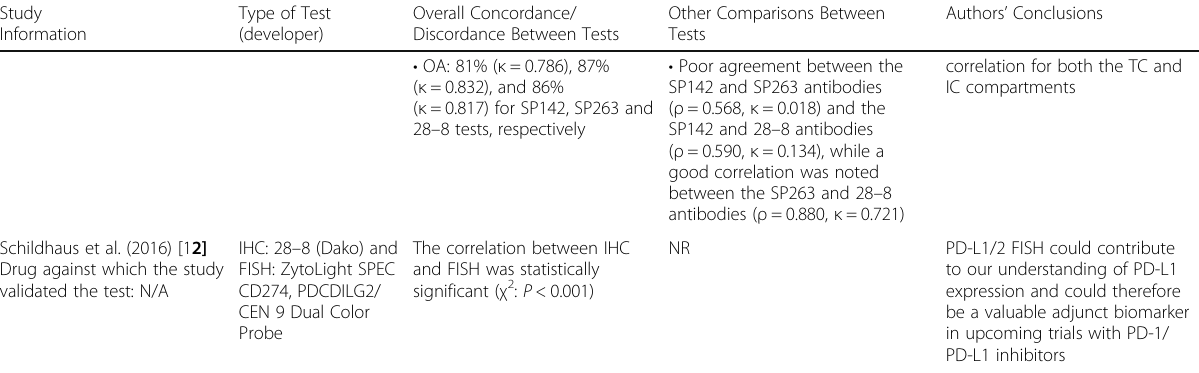
Table 4 Head-to-Head Test Performance: Test-Validation Metrics (Continued) Study Information